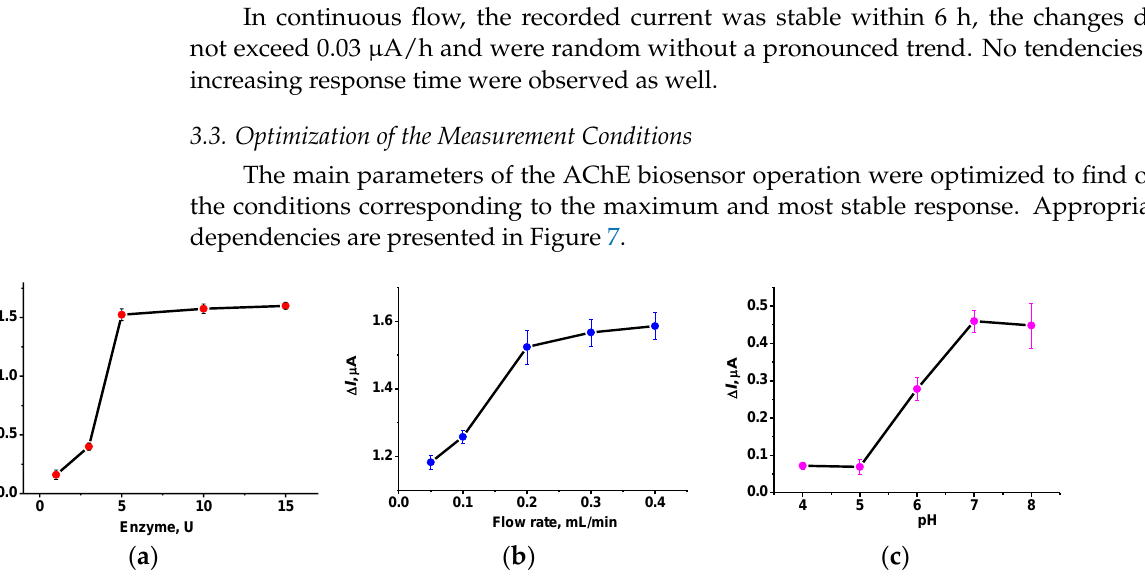
Figure 7. The dependence of the response of the AChE biosensor: ( a ) on the quantity of the enzyme taken for immobilization (ATCh 1.0 mM); ( b ) flow rate (AChE 5 U/biosensor, ATCh 1.0 mM); ( c ) pH (5 U of AChE, 0.2 mM ATCh). All the measurements at −0.25 V, average from three repetitions. Full loading of the reactor with the AChE corresponded to 5 U per biosensor. The following increase in the enzyme quantities did not alter the response to 1.0 mM. It should be also noted that the repeatability of the signal was rather high and reached 1.1% for the same reactor and 2.5% for three individual reactors and the same modified